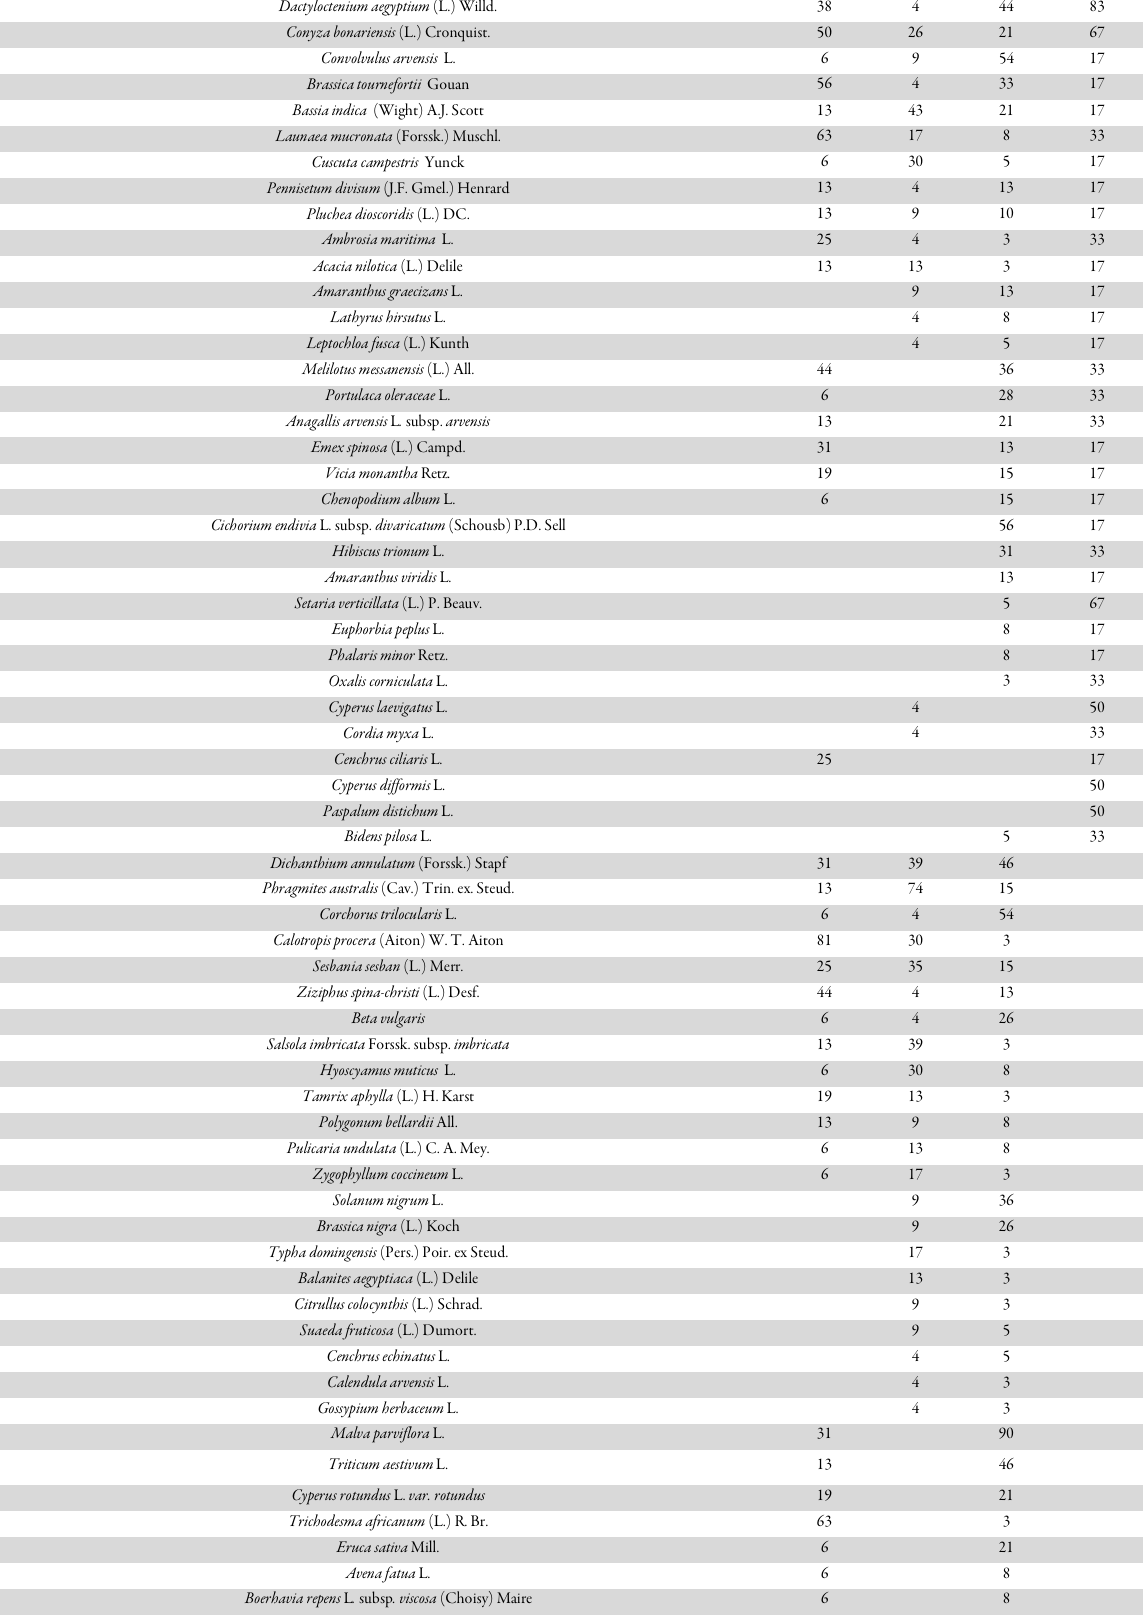
Conyza bonariensis (L.) Cronquist. Convolvulus arvensis L. Brassica tournefortii Gouan Bassia indica (Wight) A.J. Scott Launaea mucronata (Forssk.) Muschl. Cuscuta campestris Yunck Pennisetum divisum (J.F. Gmel.) Henrard Pluchea dioscoridis (L.) DC. Ambrosia maritima L. Acacia nilotica (L.) Delile Amaranthus graecizans L. Lathyrus hirsutus L. Leptochloa fusca (L.) Kunth Melilotus messanensis (L.) All. Portulaca oleraceae L. Anagallis arvensis L . subsp. arvensis Emex spinosa (L.) Campd. Vicia monantha Retz . Chenopodium album L. Cichorium endivia L. subsp. divaricatum (Schousb) P.D. Sell Hibiscus trionum L. Amaranthus viridis L. Setaria verticillata (L.) P. Beauv. Euphorbia peplus L. Phalaris minor Retz. Oxalis corniculata L. Cyperus laevigatus L. Cordia myxa L. Cenchrus ciliaris L. Cyperus difformis L. Paspalum distichum L. Bidens pilosa L. Dichanthium annulatum (Forssk.) Stapf Phragmites australis (Cav.) Trin. ex. Steud. Corchorus trilocularis L. Calotropis procera (Aiton) W. T. Aiton 81 Sesbania sesban (L.) Merr. Ziziphus spina-christi (L.) Desf. Beta vulgaris Salsola imbricata Forssk. subsp. imbricata 13 Hyoscyamus muticus L. Tamrix aphylla (L.) H. Karst Polygonum bellardii All. Pulicaria undulata (L.) C. A. Mey. Zygophyllum coccineum L. Solanum nigrum L. Brassica nigra (L.) Koch Typha domingensis (Pers.) Poir. ex Steud. Balanites aegyptiaca (L.) Delile Citrullus colocynthis (L.) Schrad. Suaeda fruticosa (L.) Dumort. Cenchrus echinatus L. Calendula arvensis L. Gossypium herbaceum L. Malva parviflora L. 31 90 Triticum aestivum L. 13 46 Cyperus rotundus L. var. rotundus 19 21 Trichodesma africanum (L.) R. Br. 63 3 Eruca sativa Mill. Avena fatua